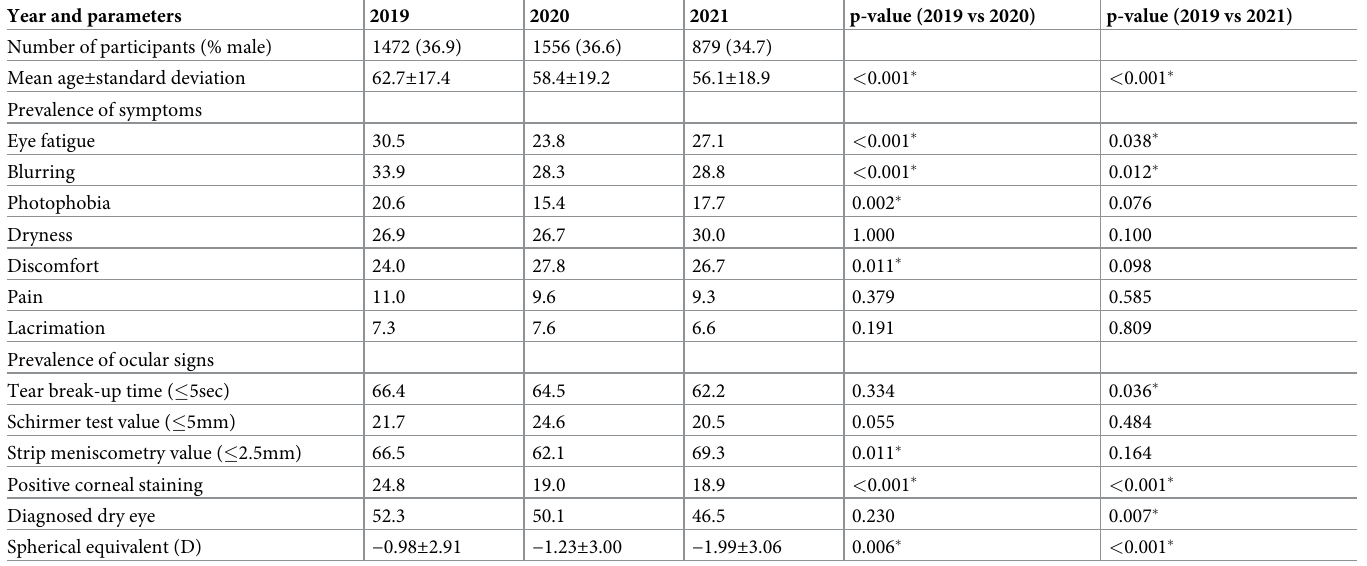
Table 1. Annual change of ocular